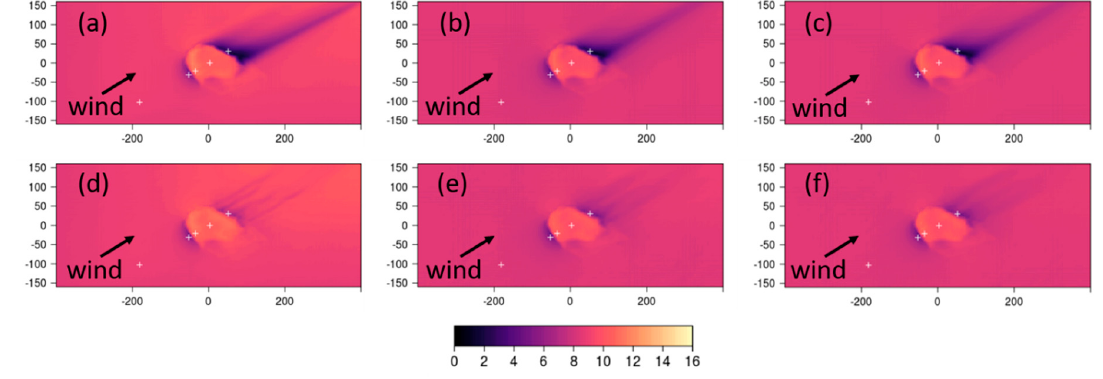
Figure 10. Same as Figure 9, but for Case 3.